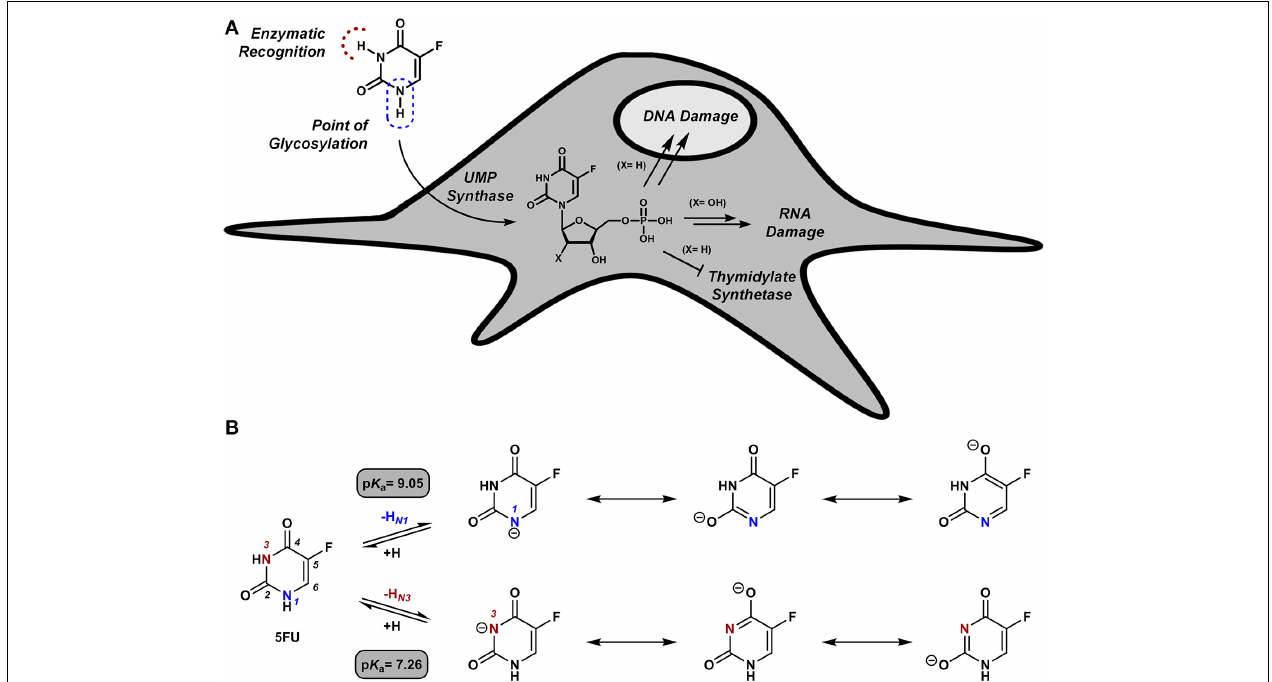
FIGURE 1 | (A) Intracellular bio-functionalization of 5FU to generate cytotoxic metabolites. (B) 5FU its conjugate bases and their theoretical p K a values (Jang et al., 2001).